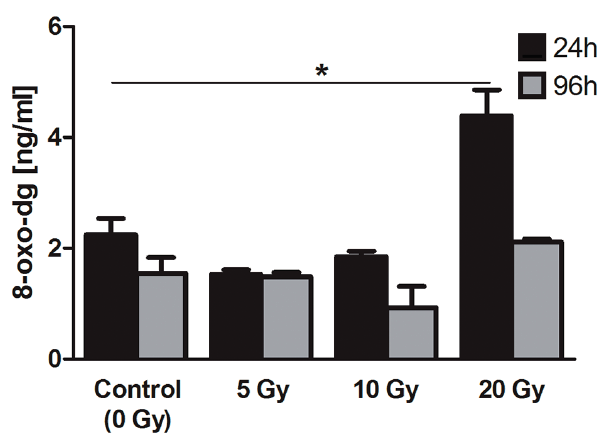
Figure 5. 8-oxo-dG concentration in human thyrocytes cultured with 131 I. The graph presents 8-oxo-dG concentration (ng/mL ± SD) in cultured thyrocytes directly after 24 h of 131 I exposure (5, 10, 20 Gy) or after additional 72 h of culture without 131 I ( * p < 0.05).